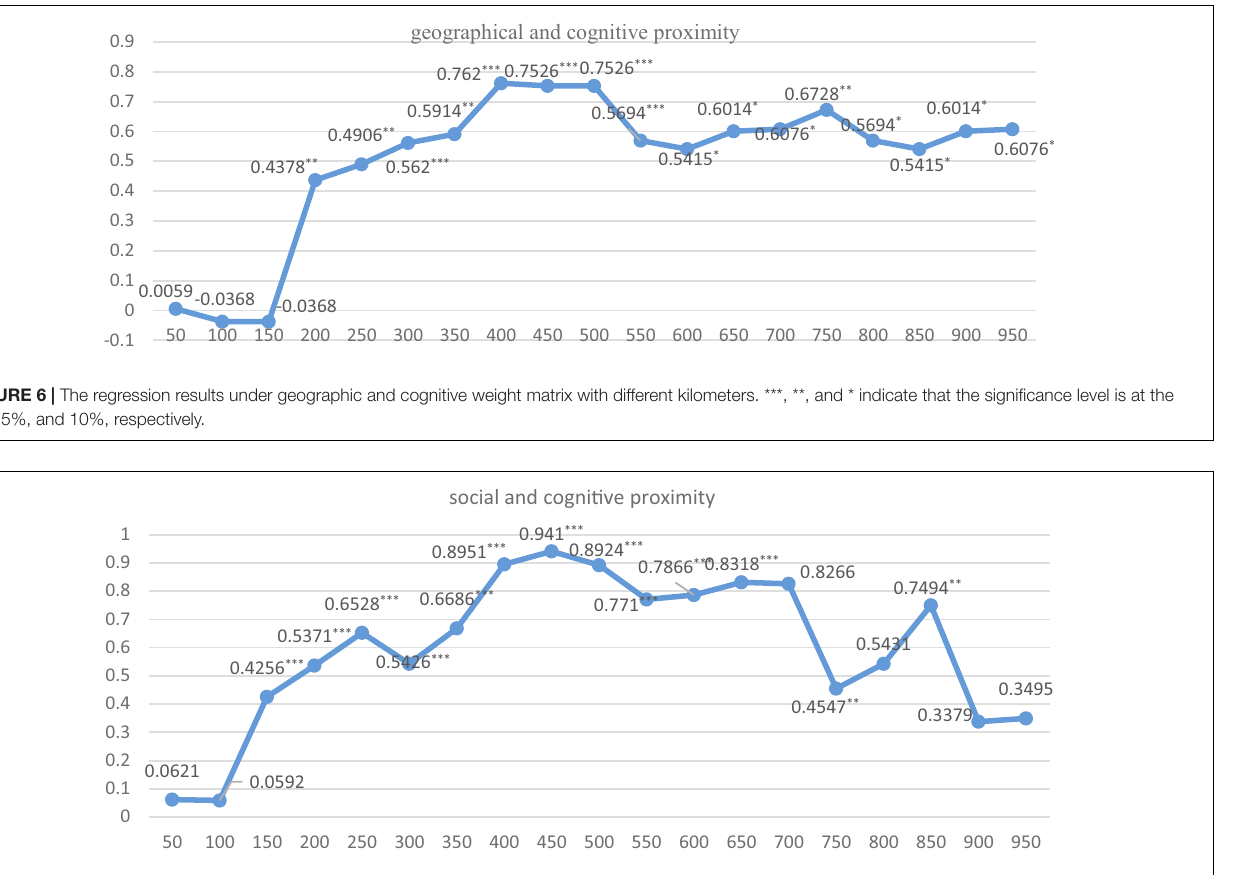
FIGURE 7 | The regression results under cognitive and social weight matrix with different kilometers. *** and ** indicate that the significance level is at the 1% and 5%,